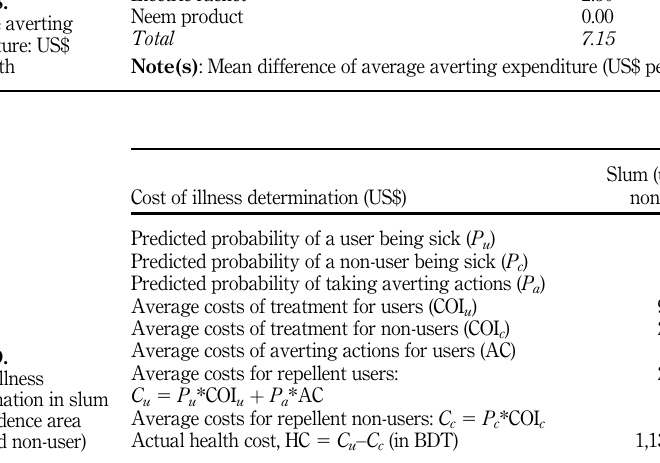
determination in slum and residence area (user and